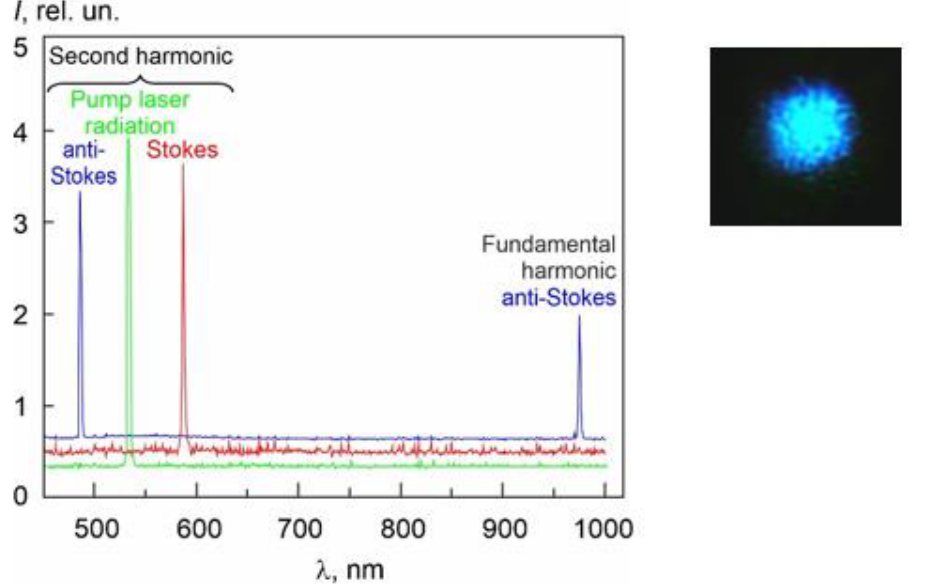
Figure 4. Spectra of the three output radiation components decomposed by a diffraction grating after frequency doubling and a photo of the anti-Stokes second-harmonic beam spot.